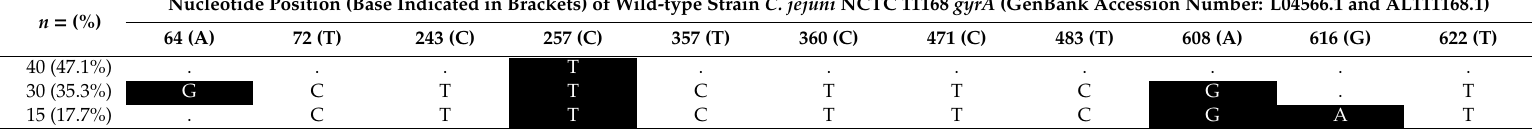
Table 1. GyrA sequence types (GTs) and associated polymorphisms distributed among 85 ciprofloxacin-resistant C. jejuni isolates (GTJs) and 14 ciprofloxacin-resistant C. coli isolates (GTCs). Polymorphisms causing an amino acid substitution (nonsynonymous mutations) are highlighted in